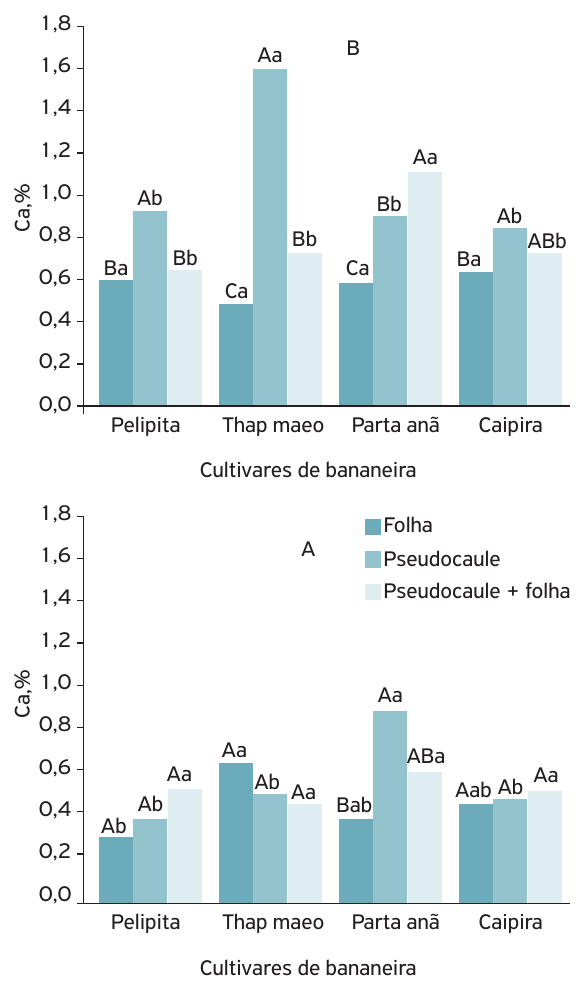
Figura 10. Teores de Ca, %, presente no substrato à base de resíduos de bananeira (pseudocaule, folha e pseudocaule + folha) de quatro cultivares de bananeira (Thap maeo, Prata anã, Pelipita e Caipira) antes (A) e após 49 dias (B) de colonização pela linhagem 09/100 de Pleurotus ostreatus . Letras maiúsculas comparam médias dentro de um mesmo cultivar de bananeira; letras minúsculas comparam médias dentro de cada tipo de resíduo. Médias seguidas de letras iguais não diferem entre si (Tukey, 5%) (Média de duas